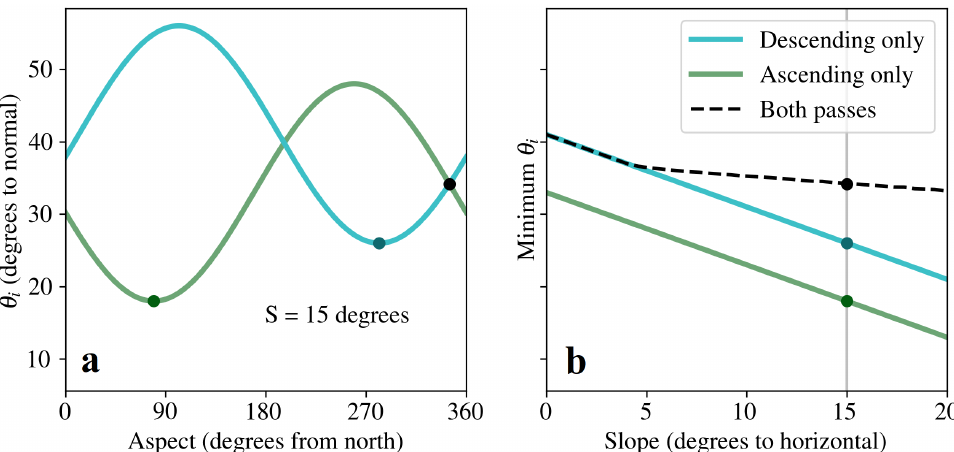
Figure 5. Analysis of local incidence angle θ i as a function of pass direction, slope (S) and aspect, as given by Equation (7). For our TDX scene, z A = 79.4 ◦ and z D = 282.0 ◦ . ( a ) For a given steepness of slope, θ i varies with the cosine of aspect. As z A − z D is close to 180 ◦ , the curves for the two pass directions are highly out of phase. ( b ) The minimum possible θ i is shown as a function of terrain slope for each pass, and for the case where pass is chosen flexibly. The dots highlight the corresponding points between the two graphs, which share the same